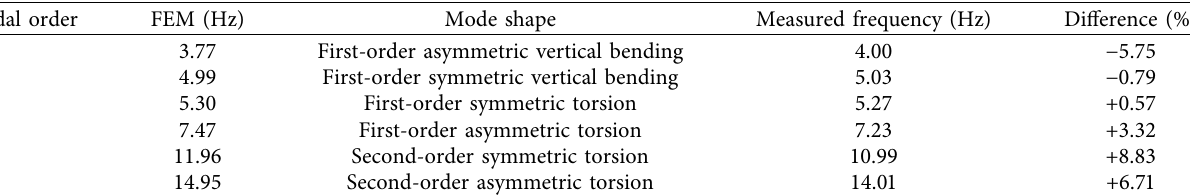
Table 1: Bridge mode from FEM in comparison with measured results.